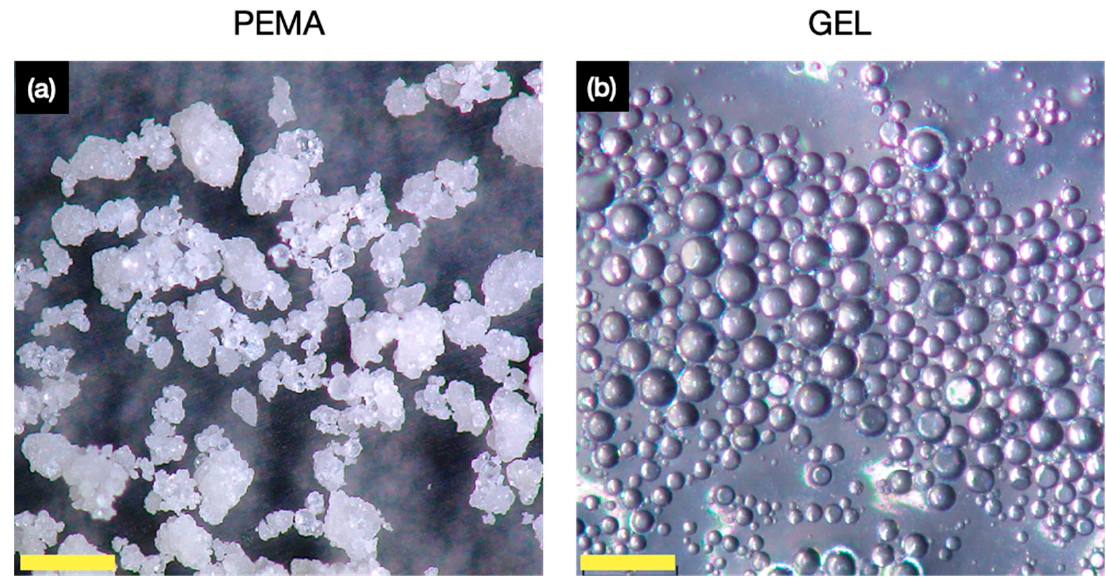
Figure 4. OM images for the tung oil microcapsules produced with ( a ) PEMA emulsifier, and ( b ) GEL emulsifier. All scale bars are 200 µm.